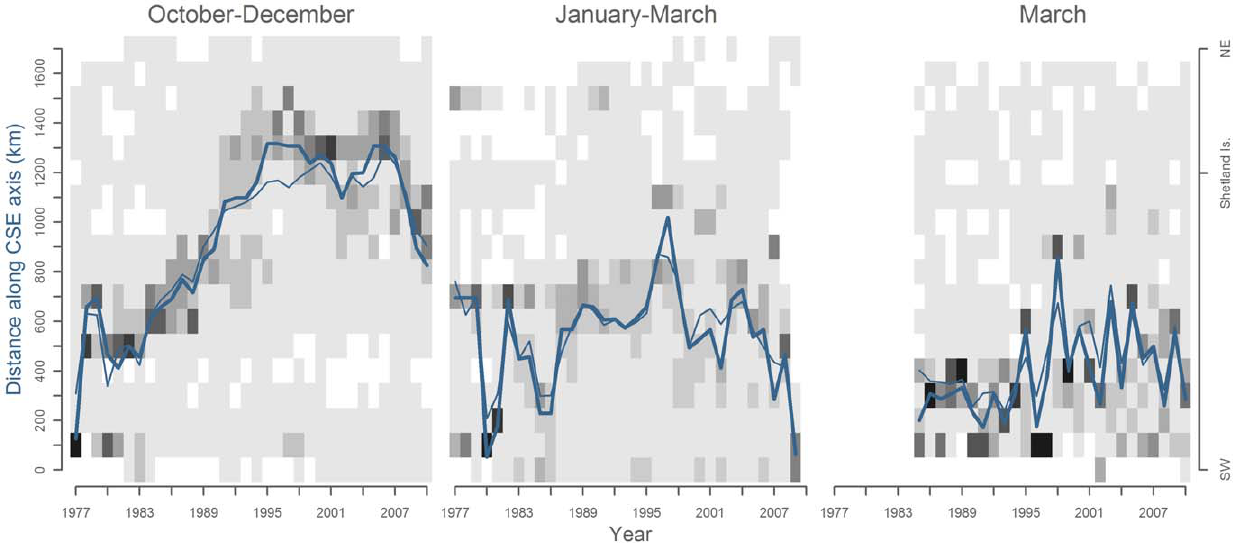
Figure 7. Hovmu¨ller plot of mackerel distributions proxies from commercial landings in October to December (left), January to March (mid) and bottom trawl surveys in March (right). The spatial aspect have been reduced to one dimention by projecting the catch location onto the CSE axis. Greyscale in cells range in 10%-steps from 0–10% (white), to 90–100% (black). Thick line represents position of 50% cumulative landings (left, mid) or CPUE (right) and thin line shows the center of gravity of the